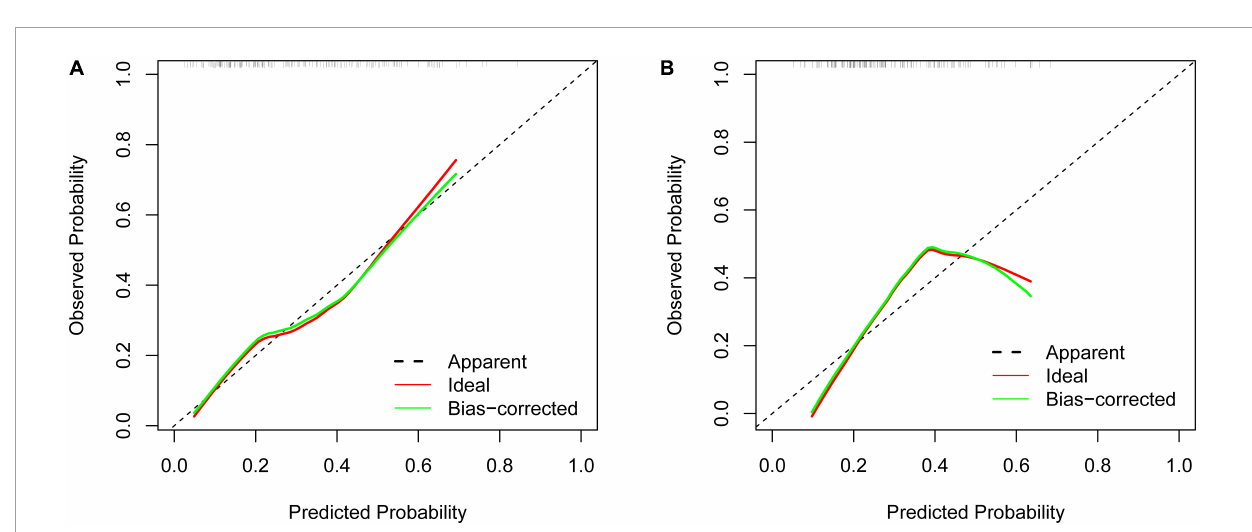
FIGURE5 Calibration curves of the predictive limb weakness risk nomogram. (A) The training set. (B) The validation